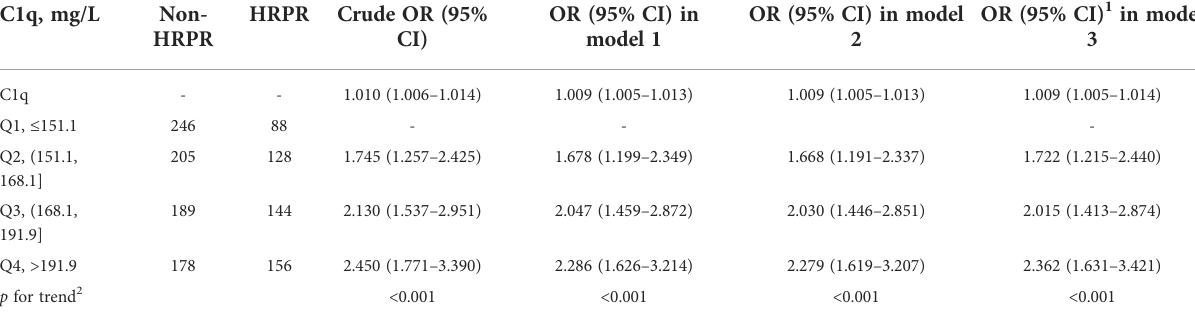
TABLE 3 Odds ratio (OR) and 95% CI for HRPR in each C1q quartile. C1q, mg/L Non- HRPR Crude OR (95% HRPR